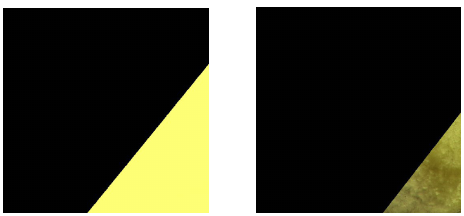
Figure 3. Example of incomplete images found in our dataset.